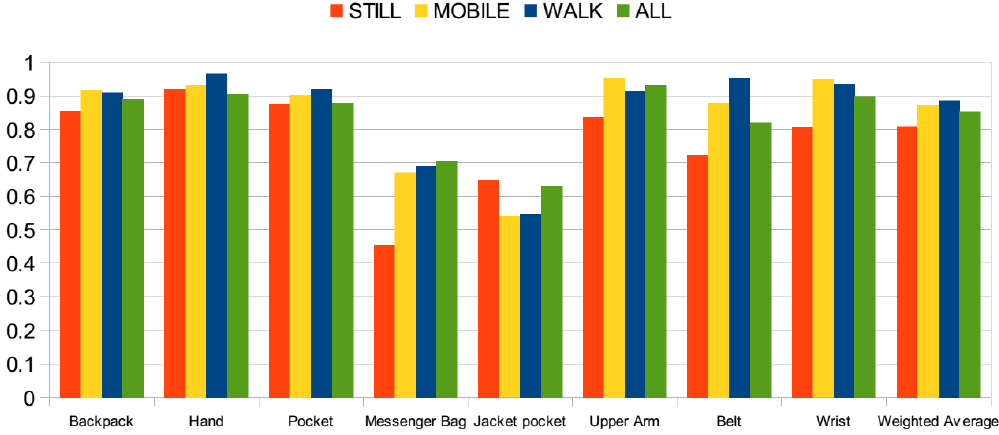
Figure 9. Accuracy when the activity information is available, datasets